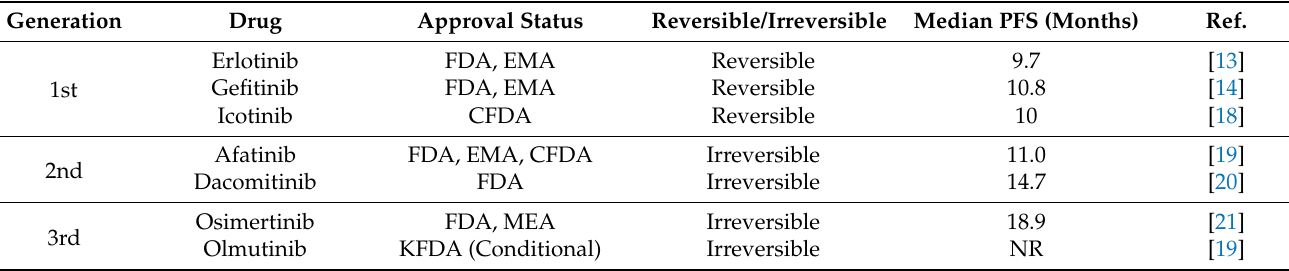
Table 1. Summary of FDA-approved